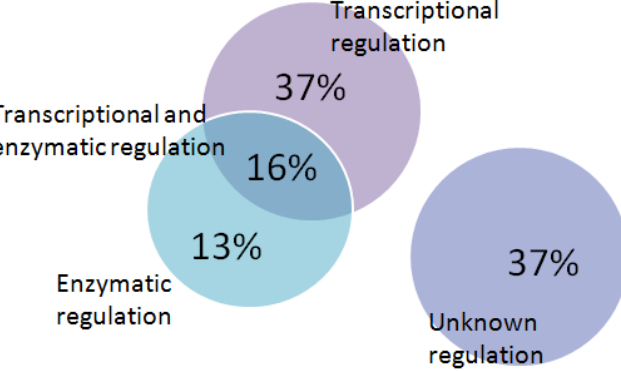
Figure 2: The different types of regulation in the E. coli